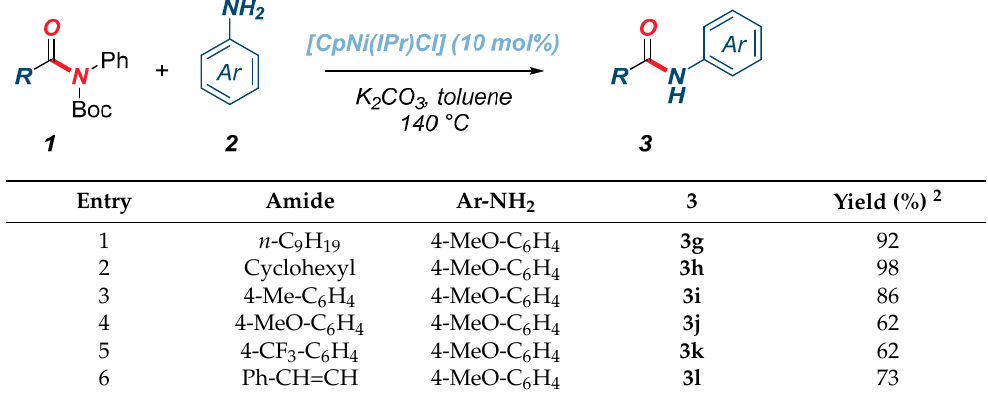
Table 3. Scope of amides in transamidation with aniline 2a using [CpNi(IPr)Cl]. 1